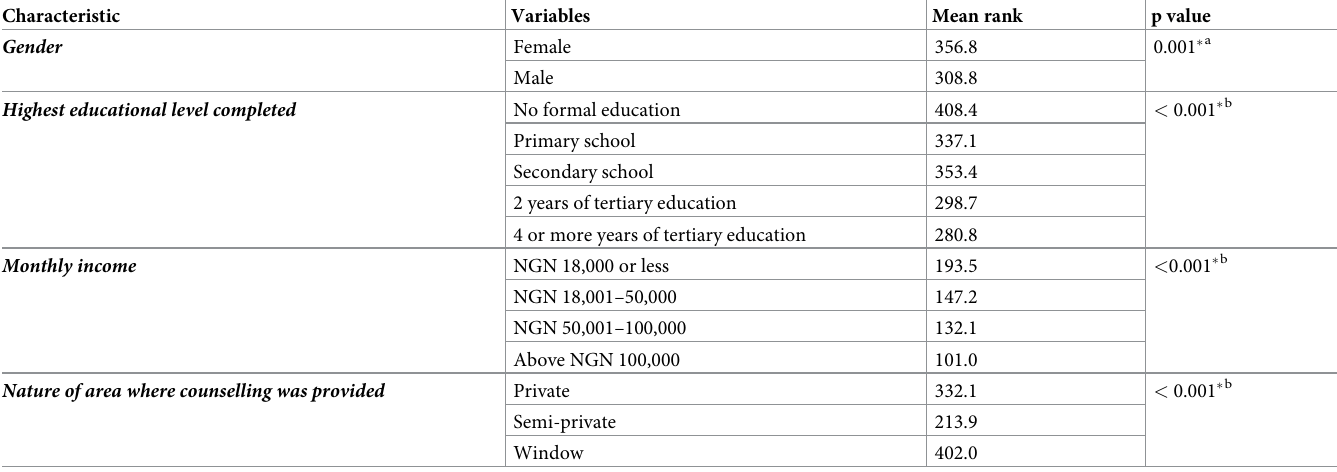
Table 3. Associations between respondent characteristics and overall satisfaction with medication counselling